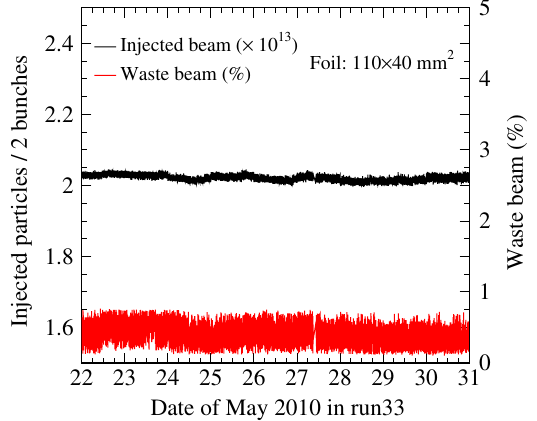
FIG. 11. A trend of the H0CT signal for about a week taken during RCS user operation for the MLF in run 33. The position of the primary stripper foil and the injected beam was optimized in such a way that the waste beam at the H0 dump was found to be as expected of 0.4% and there was no significant change of the quantity throughout the